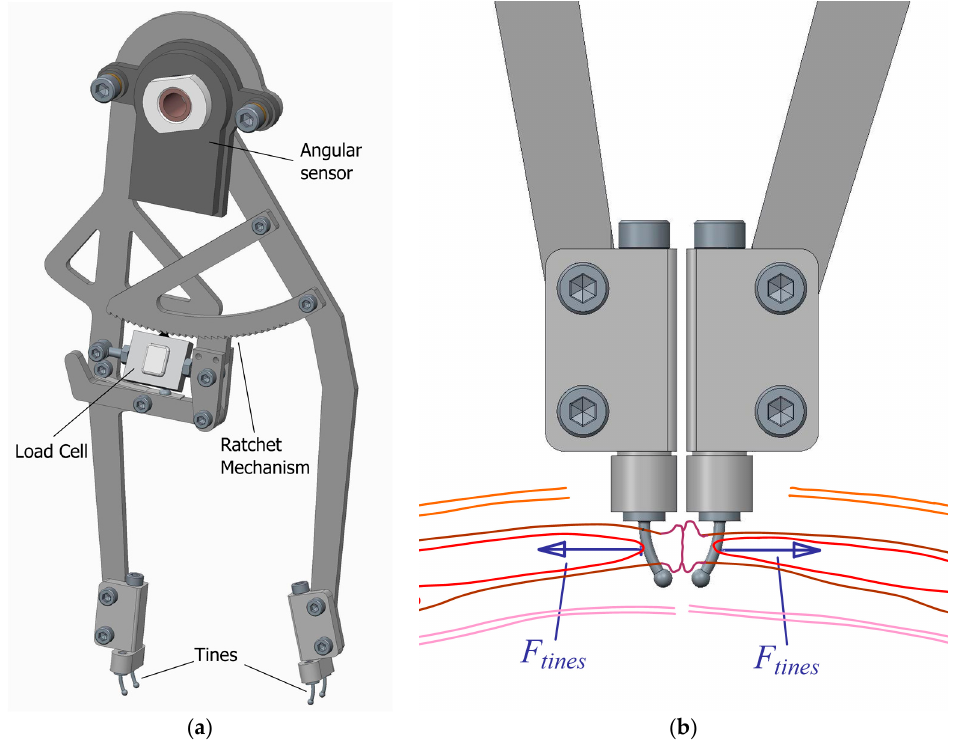
Figure 2. Instrument: ( a ) Conceptual design; ( b ) Forces applied by the aponeurotic edges to the tines.